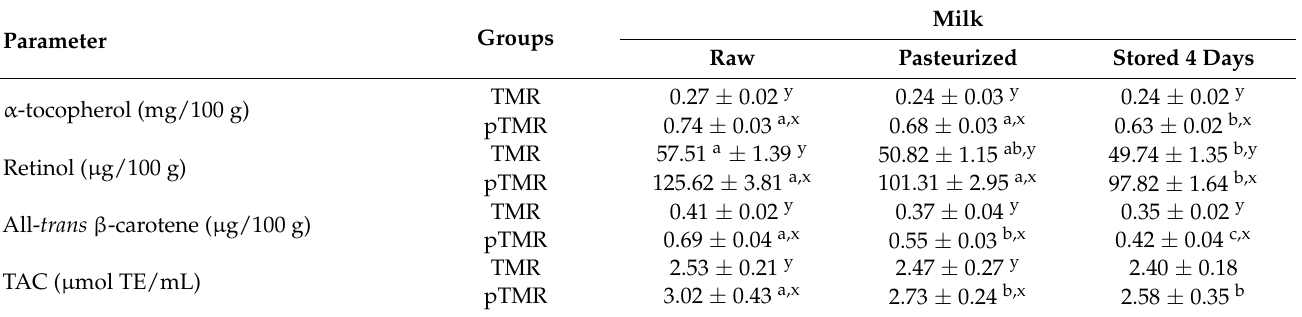
Table 6. Effect of cow feeding system (S: TMR vs. pTMR) on antioxidant content and TAC of raw, pasteurized and stored